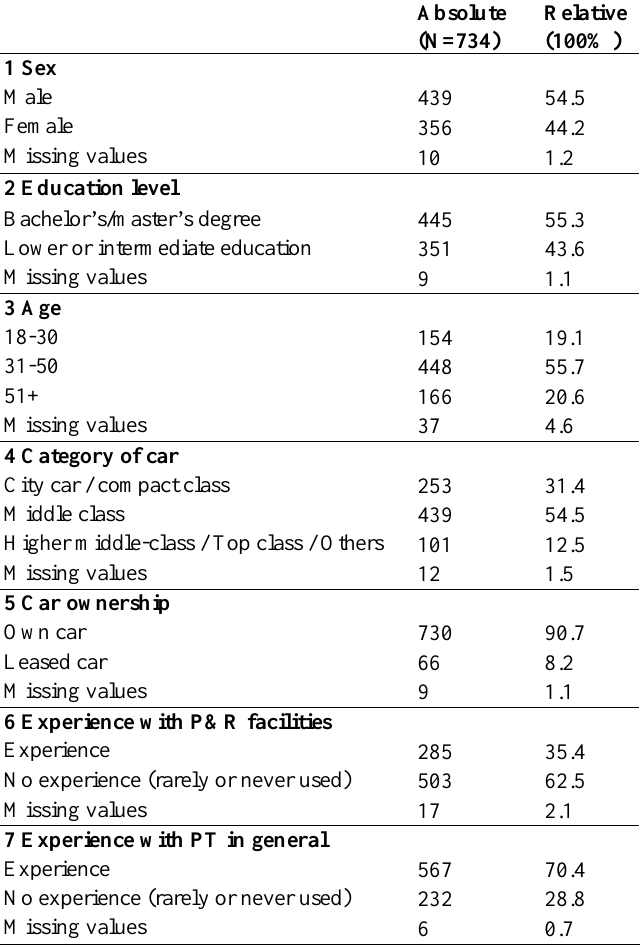
Table 2. Response group